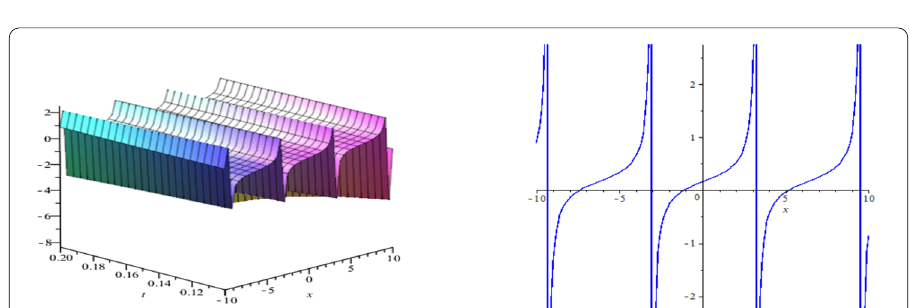
Figure 2 Modulus plot of solution (5.15), which is a singular periodic wave